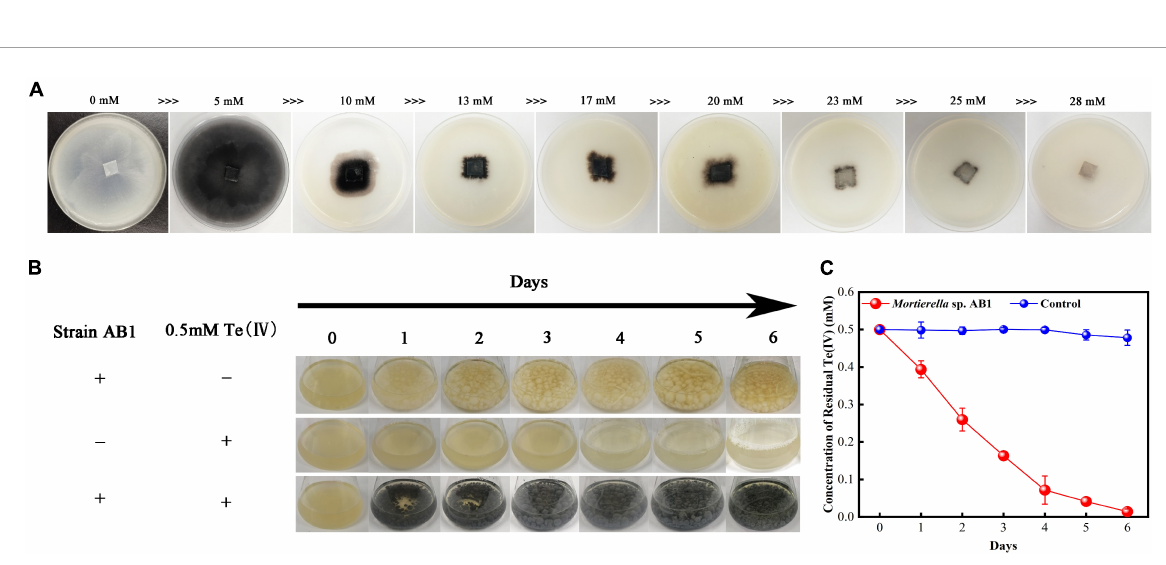
FIGURE2 Te(IV) tolerance and reducibility test. (A) Strain growth on corn meal agar plates with different concentrations of Te(IV) (0 ∼ 28 mM). (B) Strains were grown in PDB medium with or without Te(IV). (C) The reduction curve of strain AB1 under 0.5 mmol/L Te(IV) in PDB medium, and 0.5 mmol/L Te(IV) in PDB medium without strain incubation was used as a control. Data are shown as the mean ± SD of three biological